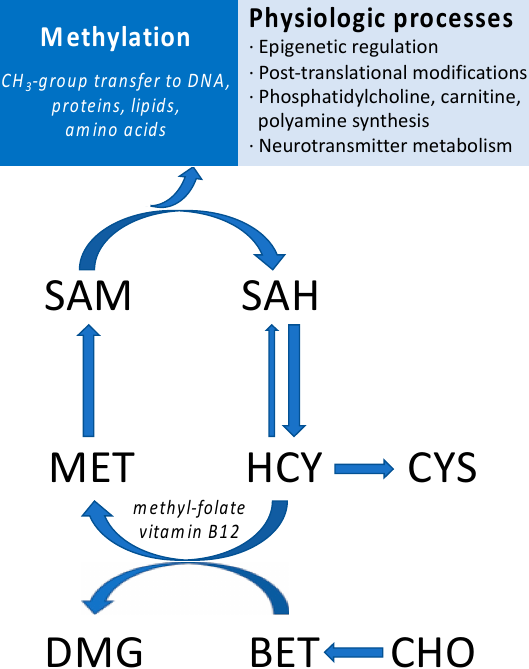
Figure 1. Schematic representation of one-carbon metabolism-associated pathways. CHO, choline; BET, betaine; MET, methionine, SAM, S-adenosylmethionine; SAH, S-adenosylhomocysteine; CYS, cystathionine; HCY, homocysteine.